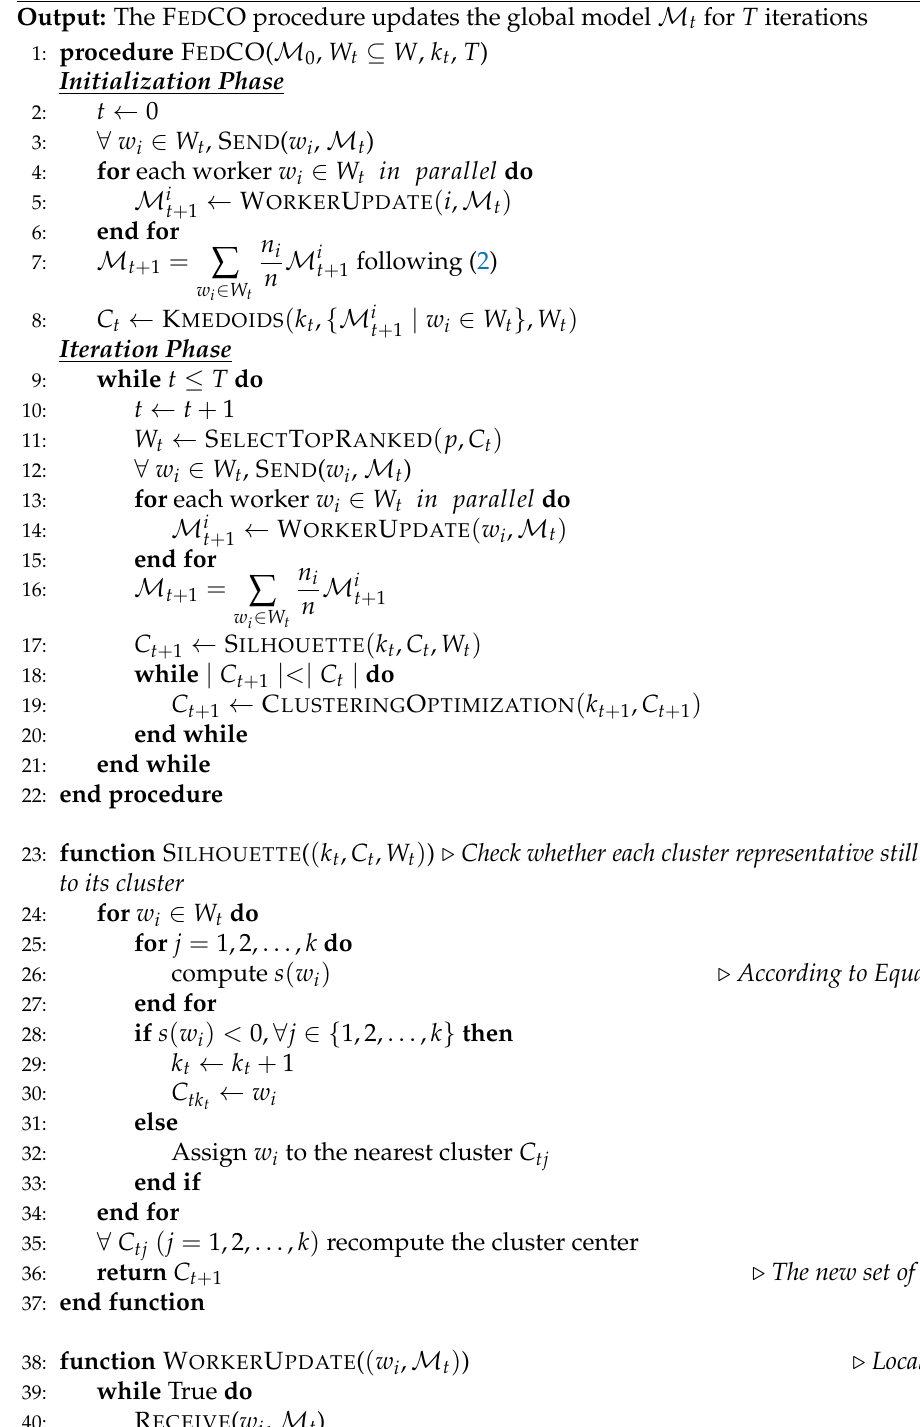
Algorithm 1 Federated Learning Using Clustering Optimization